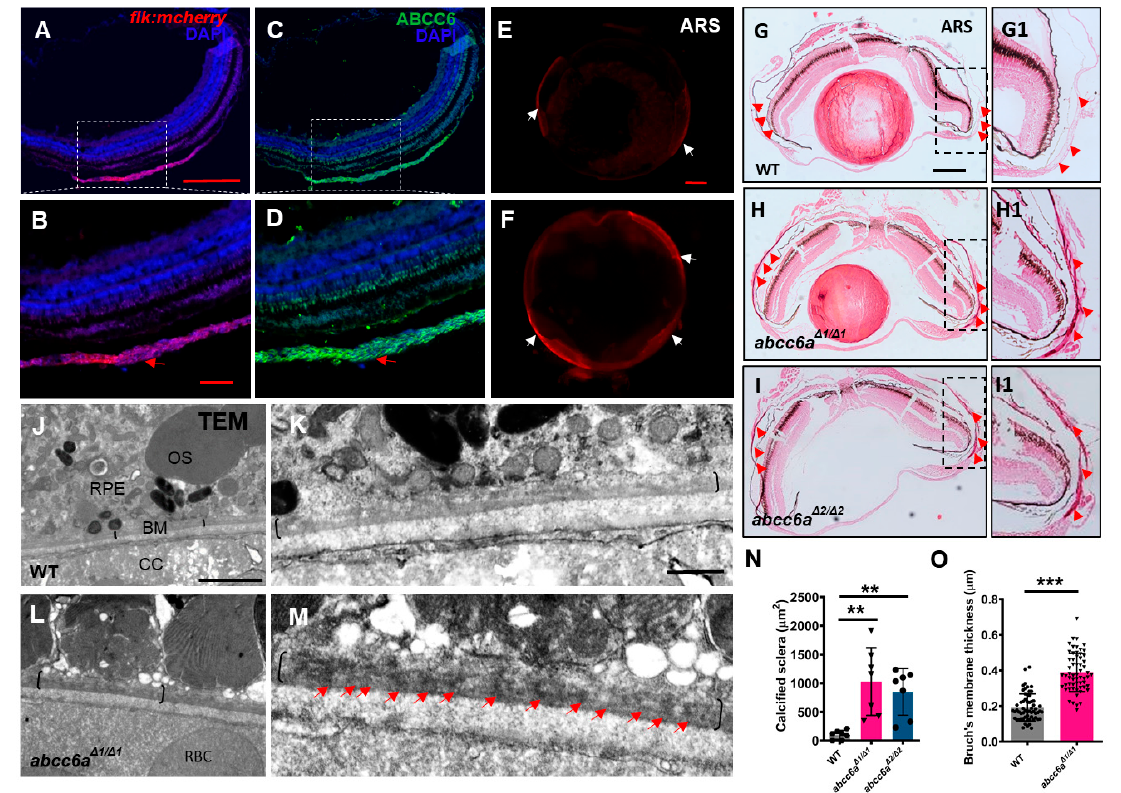
Figure 2. abcc6a mutants display ectopic calcification in the eyes. ( A – D ) Immunofluorescence results show that Abcc6 is located in the vascular-rich choroidal tissues by co-localization staining (red arrow) of Tg (flk: mcherry) fish. ( E , F ) Whole mount Alizarin Red staining shows ectopic scleral calcification in isolated eyes of abcc6a Δ 1/ Δ 1 mutants. ( G – I ; G1 – I1 ) Alizarin Red staining shows that the scleral layer of the abcc6a Δ 1/ Δ 1 and abcc6a Δ 2/ Δ 2 mutant eyes displays an accumulation of abnormal calcification ( H , I ; H1 , I1 ) compared to WT ( G , G1 ). ( G1 – I1 ) Higher-magnification images of the dashed boxes in ( G – I ). Red arrow marks abnormal calcification of scleral layer in the abcc6a Δ 1/ Δ 1 mutant eyes. ( J – M ) Transmission electron microscopy showing abnormal thickening and enrichment of dense electron core of Bruch’s membrane in abcc6a Δ 1/ Δ 1 mutant eyes ( L ), compared with WT eyes ( J ). ( K , M ) Higher-magnification images of the dashed boxes in ( J , L ). Black brackets indicate the position of BM, and red arrow indicates position of dense electron core. RPE, retinal pigment epithelium; BM, Bruch’s membrane; CC, choriocapillaris; OS, outer segment; RBC, red blood cell. ( N ) Quantification of area of calcification of sclera of WT (n = 7), abcc6a Δ 1/ Δ 1 (n = 7) and abcc6a Δ 2/ Δ 2 fish (n = 7). ** p < 0.001, Student’s t -test (unpaired, two-tailed). ( O ) Quantifi- cation of Bruch’s membrane thickness of WT (n = 6, 10 measuring points per sample) and abcc6a Δ 1/ Δ 1 (n = 6, 10 measuring points per sample) fish. *** p < 0.001, Student’s t -test (unpair, two-tailed). Scale bar: 250 μ m ( A , C ; E , F ; G – I ); 200 μ m ( B , D );62.5 μ m ( G1 – I1 ); 2 μ m ( J , L ); 0.5 μ m ( K , M ).